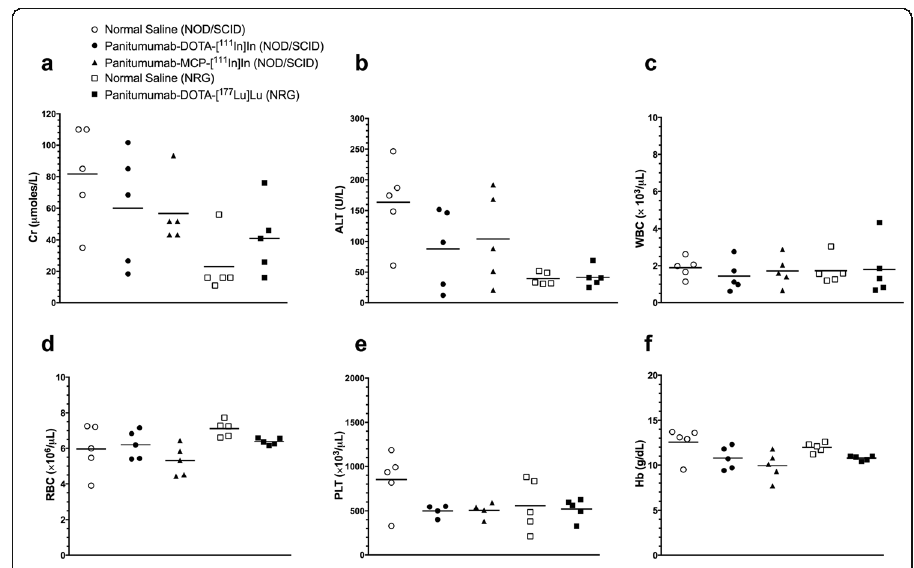
Fig. 3 a Serum creatinine (Cr), b Alanine aminotransferase (ALT), c White blood cells (WBC), d Red blood cells (RBC), e Platelets (PLT), and ( f ) hemoglobin (Hb) in non-tumour bearing NOD/SCID mice at two weeks after i.v. injection (tail vein) of 10.0 MBq (10 μ g; ~ 0.07 nmoles) of panitumumab-DOTA-[ 111 In]In, panitumumab-MCP-[ 111 In]In or normal saline, or in NRG mice injected i.v. with 6.0 MBq (10 μ g; ~ 0.07 nmoles) of panitumumab-DOTA-[ 177 Lu]Lu. Individual values and mean values (horizontal lines) are